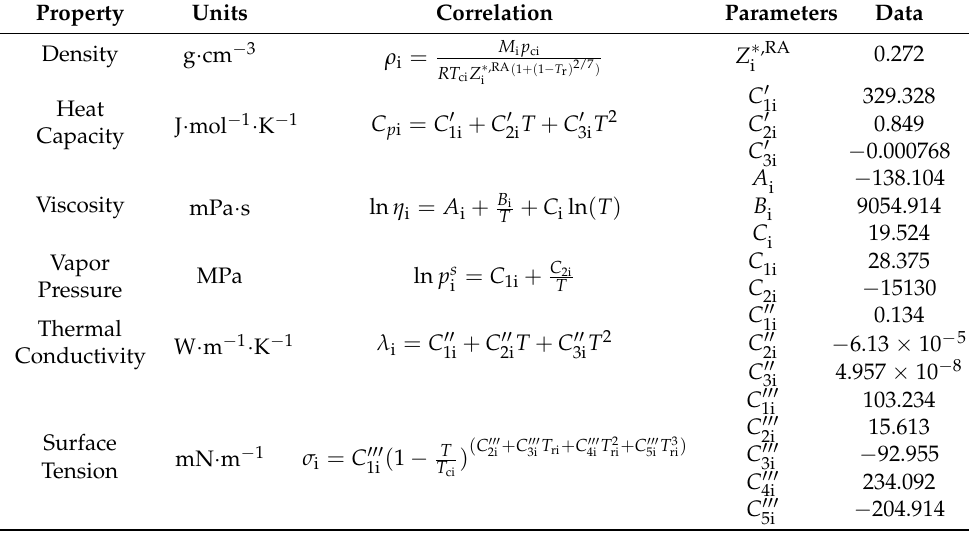
Table 1. Correlations and parameters developed for various properties of [emim][Tf 2 N].